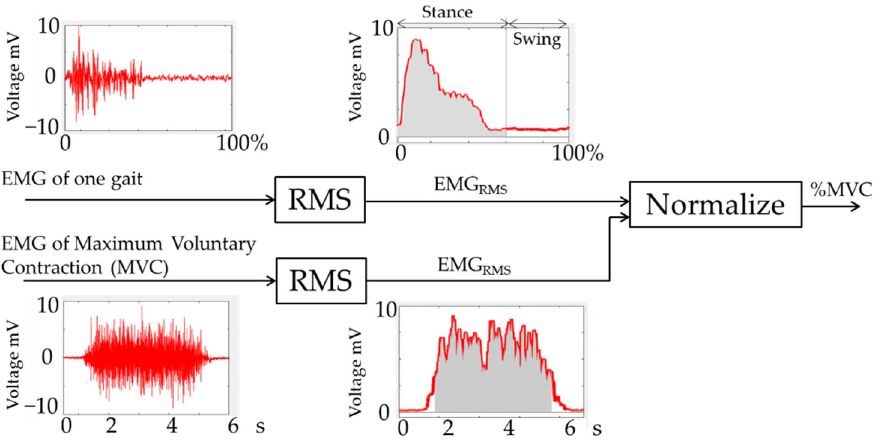
Figure 13. EMG data processing workflow.